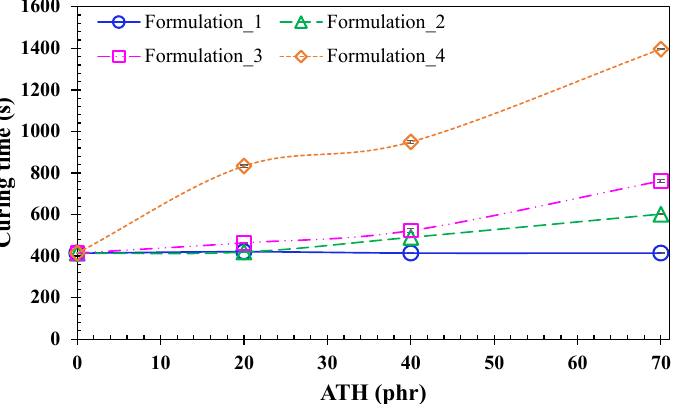
Figure 3. Curing degree behavior for the four groups of formulation as a function of the amount of filler in the neat UV resin system. Depicted lines are for visual interpretation.